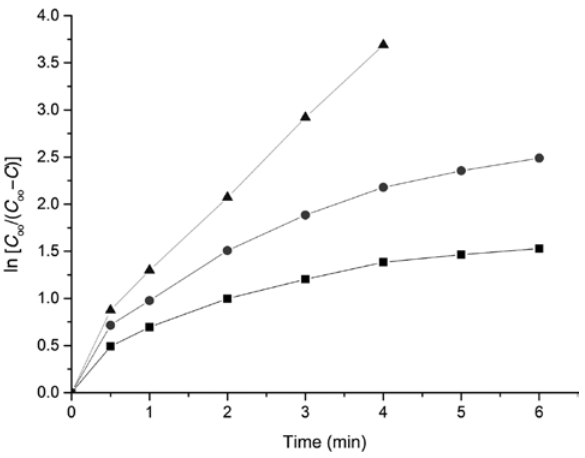
/( C – C )] versus time ∞ ∞